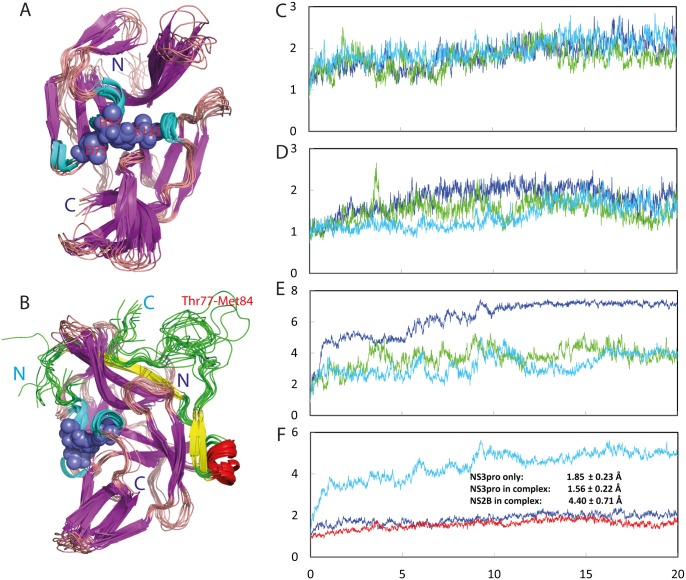
Overall dynamic behaviors in the MD simulations.Structure snapshots (one structure for 2-ns interval) of the first MD simulations respectively for the isolated NS3pro (A) and NS2B-NS3pro complex (B). Root-mean-square deviations (RMSD) of the Cα atoms (from their positions in the energy minimized structures) for three independent MD simulations of the isolated NS3pro (C), the NS3pro (D) and NS2B (E) in the context of the NS2B-NS3pro complex. (F) RMSD trajectories averaged over three independent MD simulations of the isolated NS3pro (blue), the NS3pro (red) and NS2B (cyan) in the context of the NS2B-NS3pro complex.